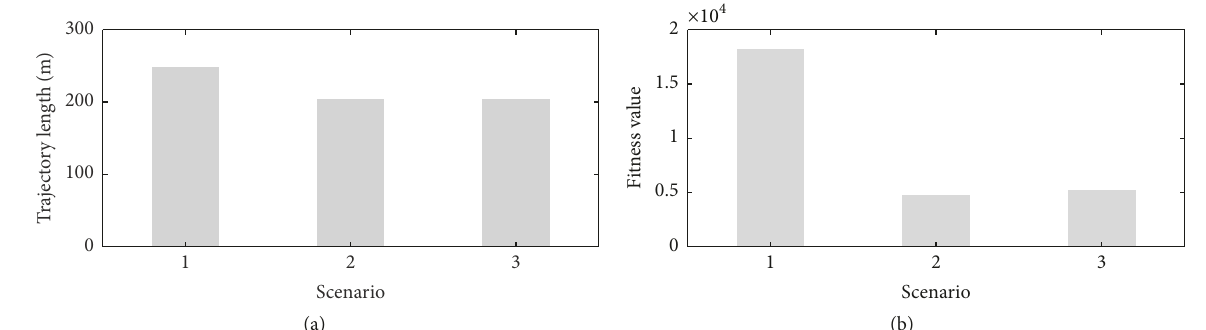
Figure 9: Performance criterion: (a) trajectory length and (b) fitness value,